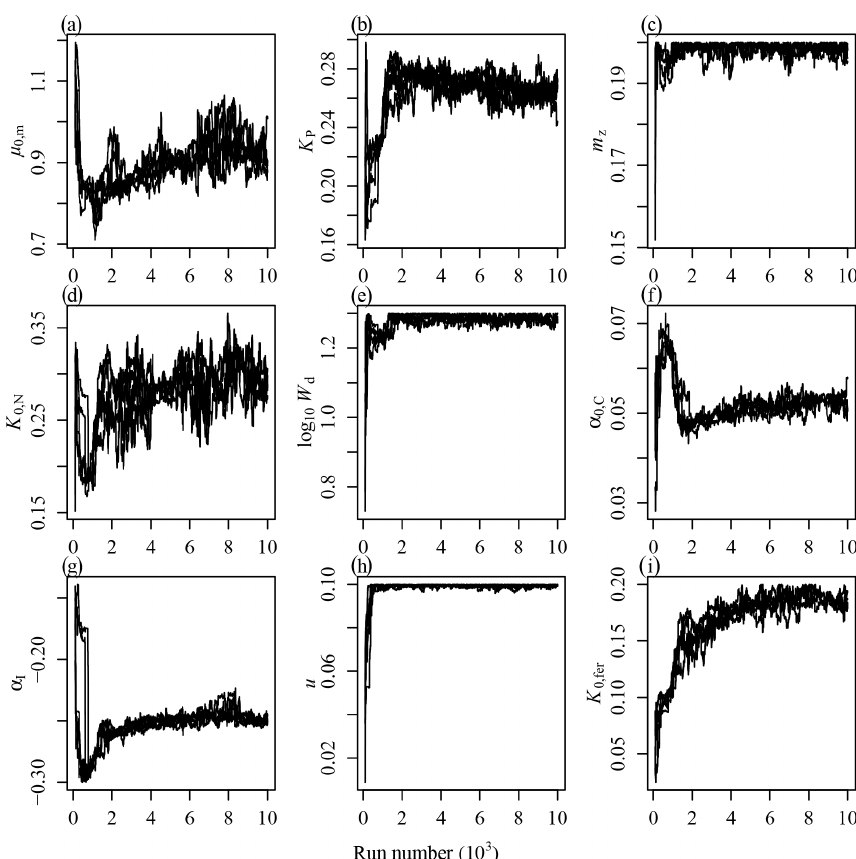
Figure 5. Time evolution of fitted model parameters. Note that K P is the microzooplankton grazing half-saturation constant.